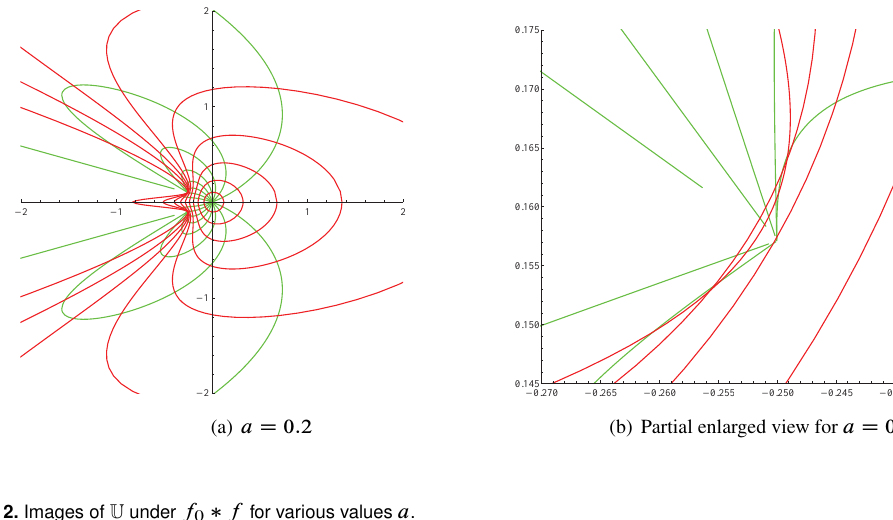
Fig. 1. Images of U under f 0 (cid:3) f for a D 0:2 .